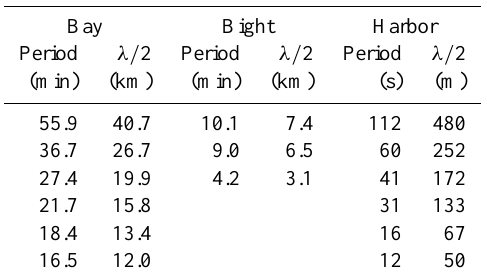
Table 1. Spatial scales of the bay, bight and harbor modes according to the dispersion relation ω 2 = gk tanh (kd) where ω is frequency, k the wave number, d the water depth and λ the wavelength. The bay and bight modes use depths of 60m, the harbor modes